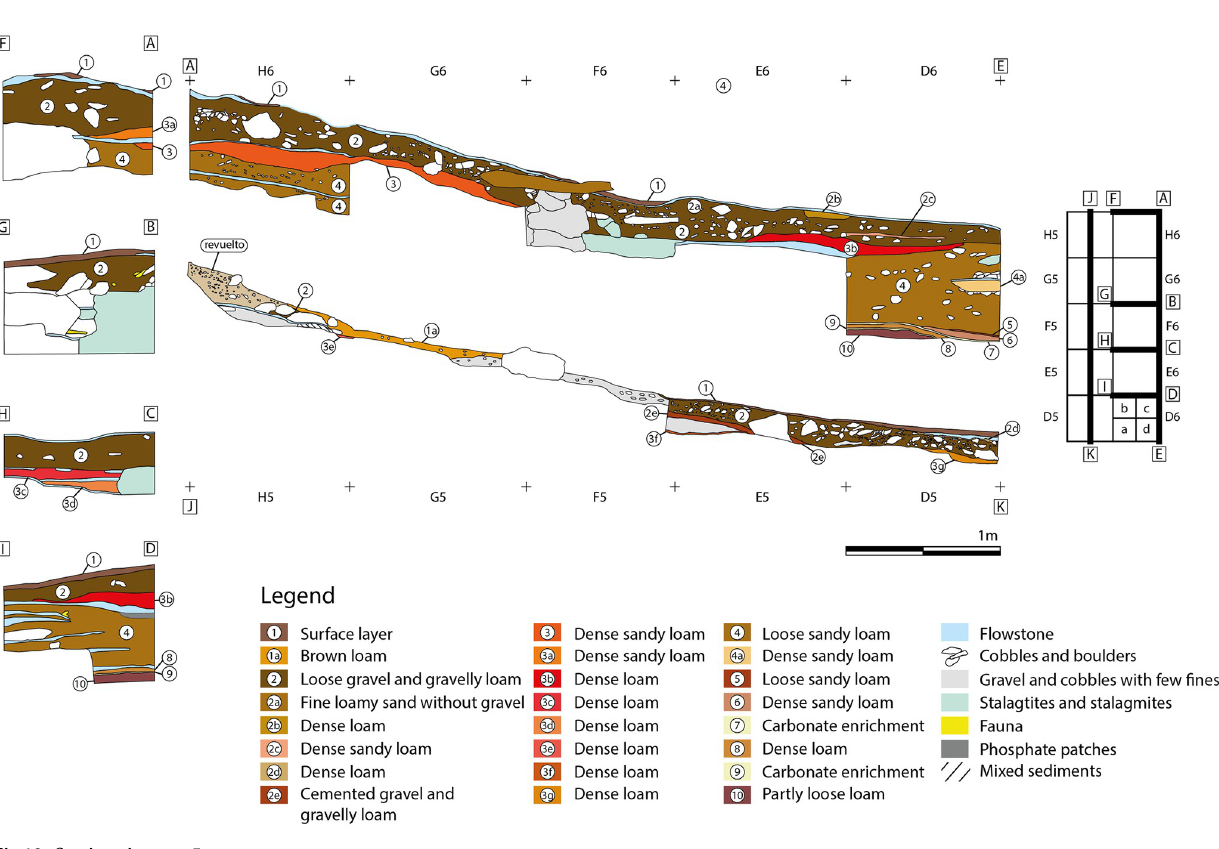
Fig 10. Sections in zone 5.